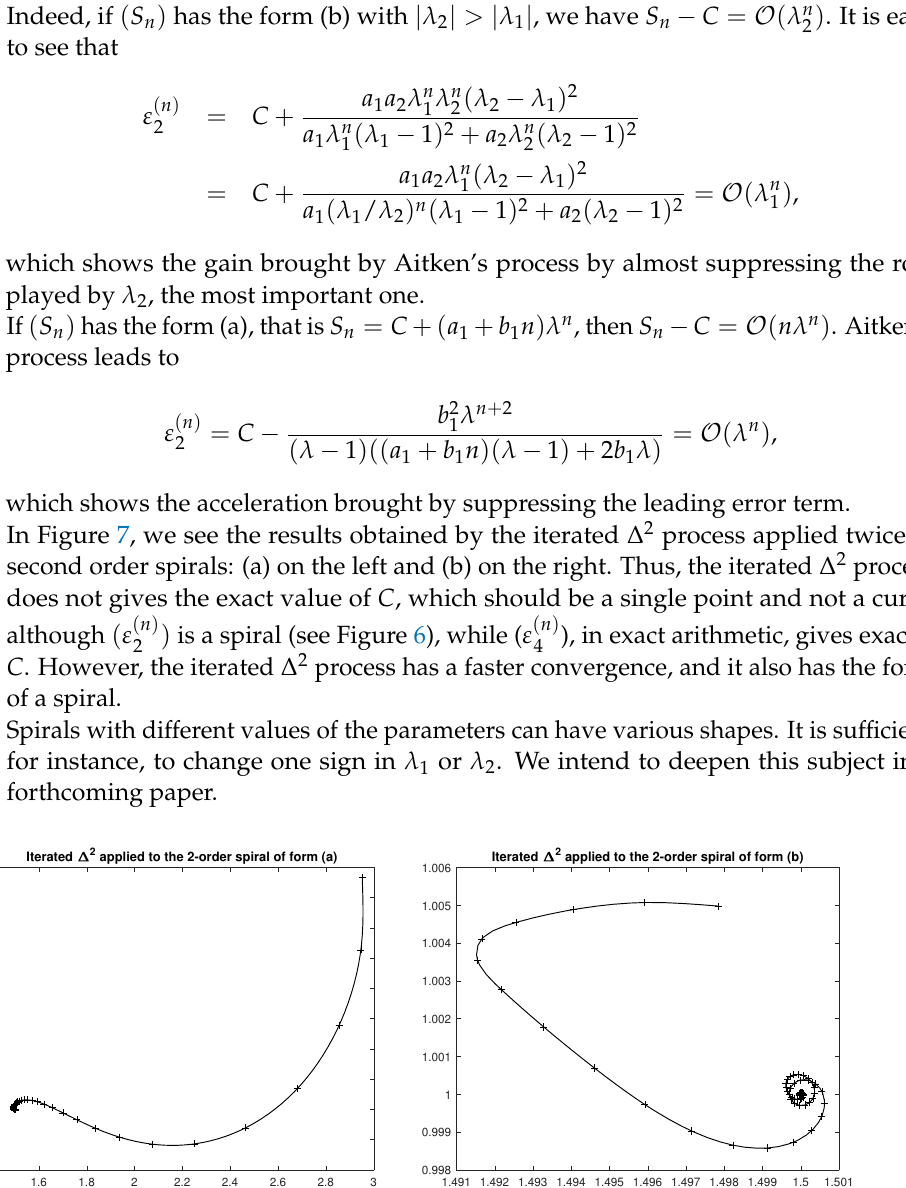
Figure 6. ∆ 2 process applied to second order spirals: (a) on the left and (b) on the right .